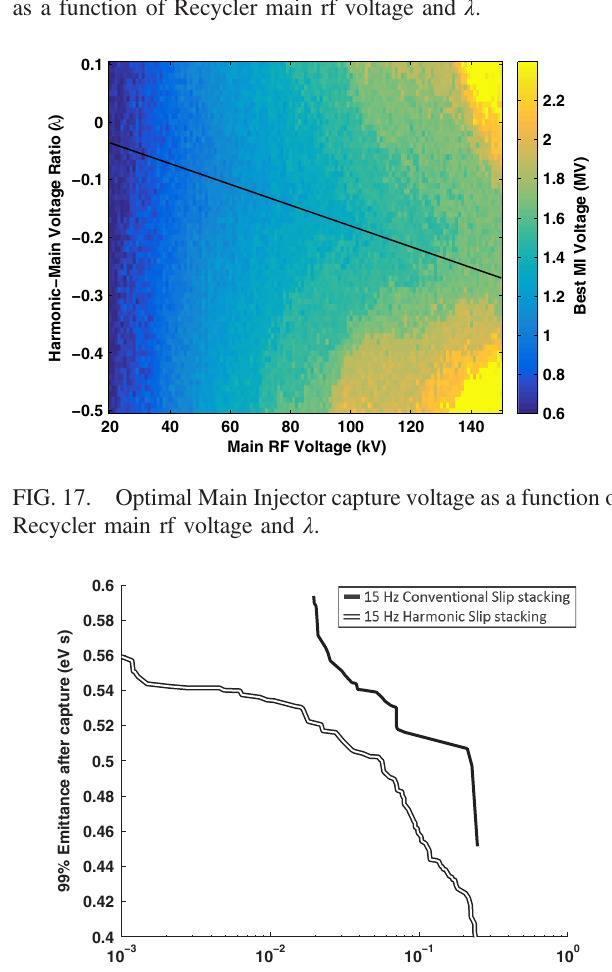
FIG. 16. Longitudinal emittance after capture in Main Injector, as a function of Recycler main rf voltage and λ .